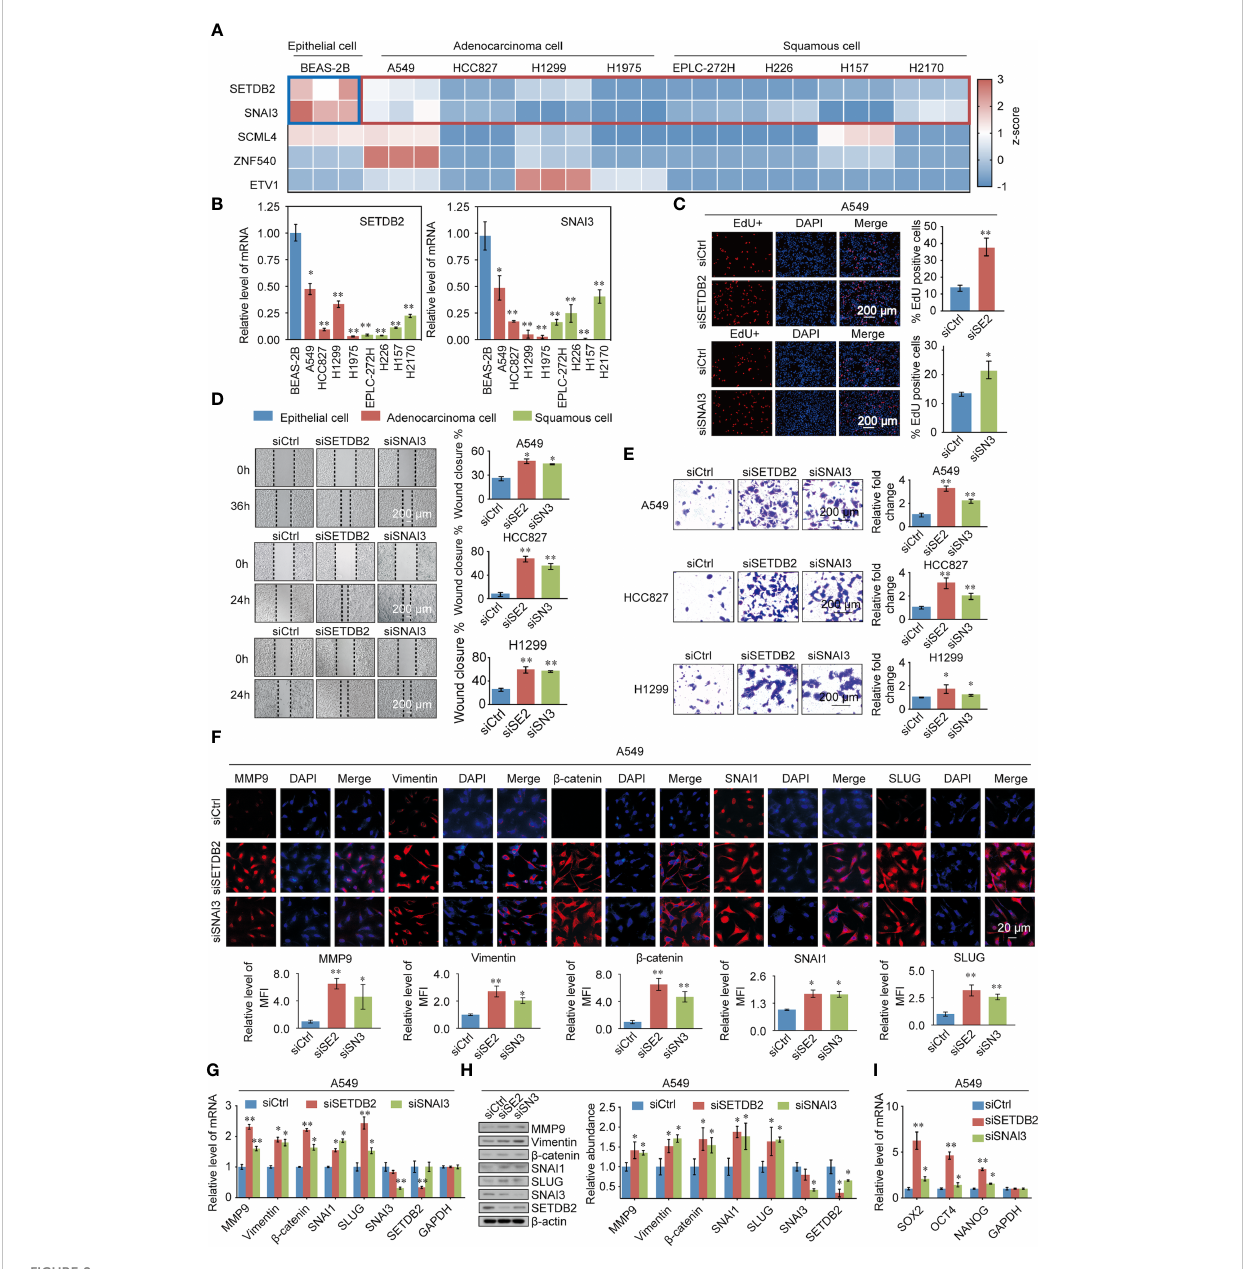
FIGURE 8 Validating the TFs phenotypes, functions, and expression in lung cancer. (A) SETDB2, SNAI3, SCML4, ZNF540, and ETV1 mRNA expression levels in the normal human bronchial epithelial cell line (BEAS-2B), lung adenocarcinoma cell lines (A549, HCC827, H1299, and H1975), and lung squamous cell lines (EPLC-272H, H226, H157, and H2170) using RT-qPCR. Blue box: normal human bronchial epithelial cell line (BEAS-2B). Red box: lung cancer cell lines. (B) The mRNA expression levels of SETDB2 and SNAI3 in the normal human bronchial epithelial cell line (BEAS-2B), lung adenocarcinoma cell lines (A549, HCC827, H1299, and H1975), and lung squamous cell lines (EPLC-272H, H226, H157, and H2170) using RT-qPCR. (C) EdU assays were performed in A549 cells infected with siCtrl, siSETDB2, and siSNAI3. siCtrl, siControl; siSE2, siSETDB2; siSN3, siSNAI3. (D) Wound healing experiments were performed in A549, HCC827, and H1299 transfected with siCtrl, siSETDB2, and siSNAI3. siCtrl, siControl; siSE2, siSETDB2; siSN3, siSNAI3. (E) Transwell invasion assays were performed on lung cancer cells (A549, HCC827, and H1299) infected with siCtrl, siSETDB2, and siSNAI3. siCtrl, siControl; siSE2, siSETDB2; siSN3, siSNAI3. (F) Immuno fl uorescence staining including MMP9, Vimentin, b -catenin, SNAI1 and SLUG was performed in A549 cells transfected with siCtrl, siSETDB2 and siSNAI3. Blue fl uorescence of DAPI labeled cell nucleus, red fl uorescence of labeled corresponding protein. siCtrl, siControl; siSE2, siSETDB2; siSN3, siSNAI3. MFI, mean fl uorescence intensity. (G) The mRNA expression levels of metastatic markers (MMP9, Vimentin, b -catenin, SNAI1, and SLUG) as well as SNAI3 and SETDB2 were detected by RT-qPCR in A549 cells transfected with siCtrl, siSETDB2, and siSNAI3. siCtrl, siControl. (H) The protein levels of metastatic markers (MMP9, Vimentin, b -catenin, SNAI1, and SLUG) as well as SNAI3 and SETDB2 were detected by western blotting in A549 cells transfected with siCtrl, siSETDB2, and siSNAI3. siCtrl, siControl; siSE2, siSETDB2; siSN3, siSNAI3. (I) The mRNA expression levels of stem cell markers (SOX2, OCT4, and NANOG) in A549 cells transfected with siCtrl, siSETDB2, and siSNAI3 using RT-qPCR. siCtrl, siControl. (B-E, G, I) Error bar represents mean ± SD of three independent experiments. * p < 0.05, ** p < 0.01. Student ’ s